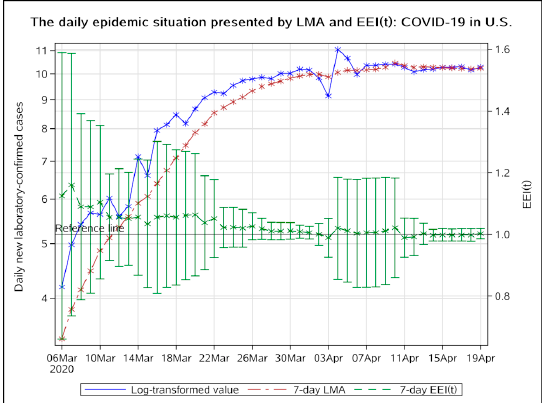
Figure 8. The daily epidemic situation presented by LMA and EEI(t), COVID-19 in the USA. The blue line indicates the change of the log-transformed value over date. The brown line indicates the change of 7-day LMA over date. The green line indicates the change of the EEI(t) over date. LMA, moving average of log-transformed daily new cases and EEI(t), epidemic evaluation index (t).